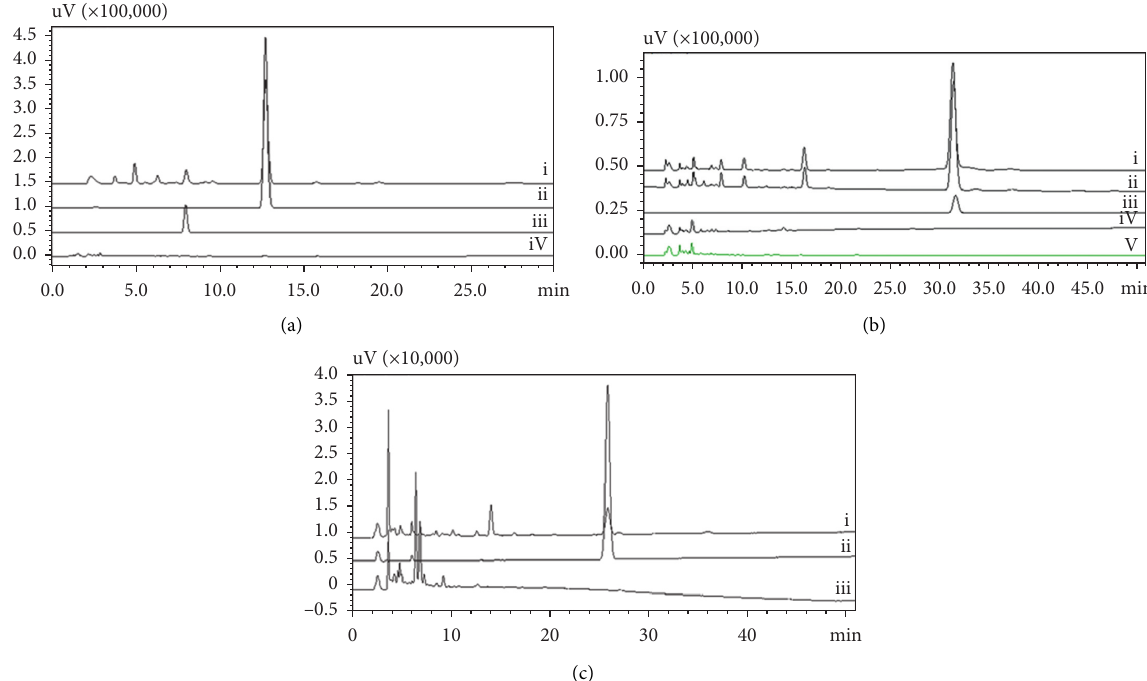
Figure 2: (a) HPLC chromatogram of biotransformation of daidzein, where (i) Streptomyces species G-18 with daidzein, (ii) daidzein, (iii) 7,3 ′ ,4 ′ -trihydroxyisoflavone, and (iv) Streptomyces species G-18 without daidzein. (b) HPLC chromatogram of biotransformation of genistein, where (i) Streptomyces species G-14 with genistein, (ii) Streptomyces species G-18 with genistein, (iii) genistein, (iv) Streptomyces species G-18 without genistein, and (v) Streptomyces species G-14 without Genistein. (c) HPLC chromatogram of biotransformation of naringenin, where (i) Streptomyces species S4L with naringenin, (ii) naringenin, and (iii) Streptomyces species S4L without naringenin.